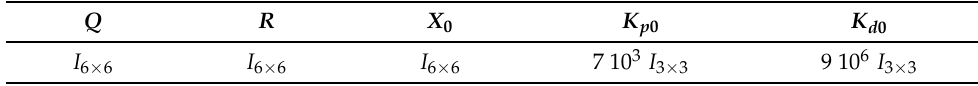
Table A1. Parameters for gain selection. Q